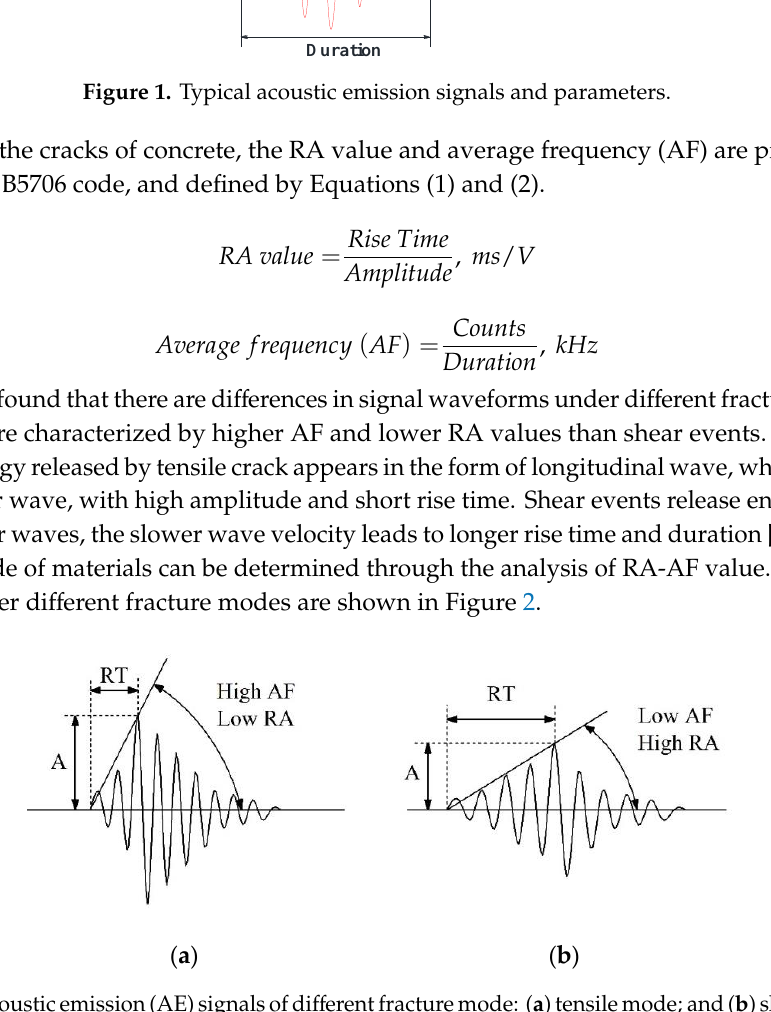
Figure 2. Acoustic emission (AE) signals of different fracture mode: ( a ) tensile mode; and ( b ) shear mode.